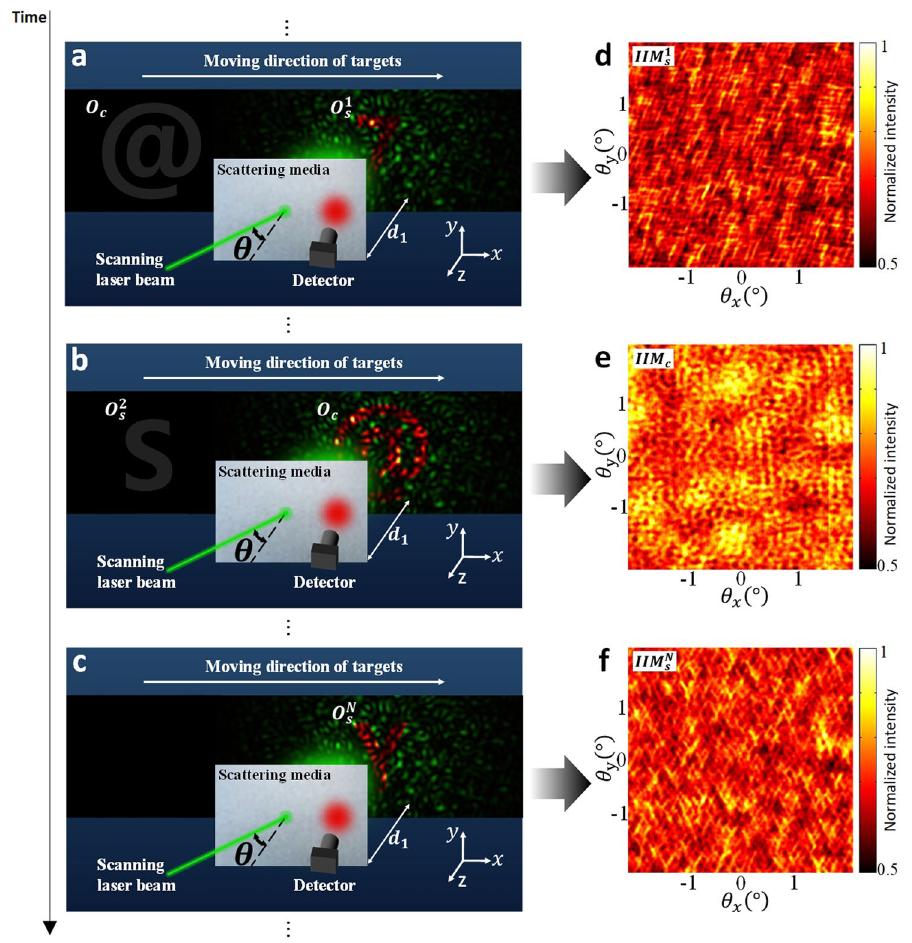
are training target and to-be-observed target, c x y